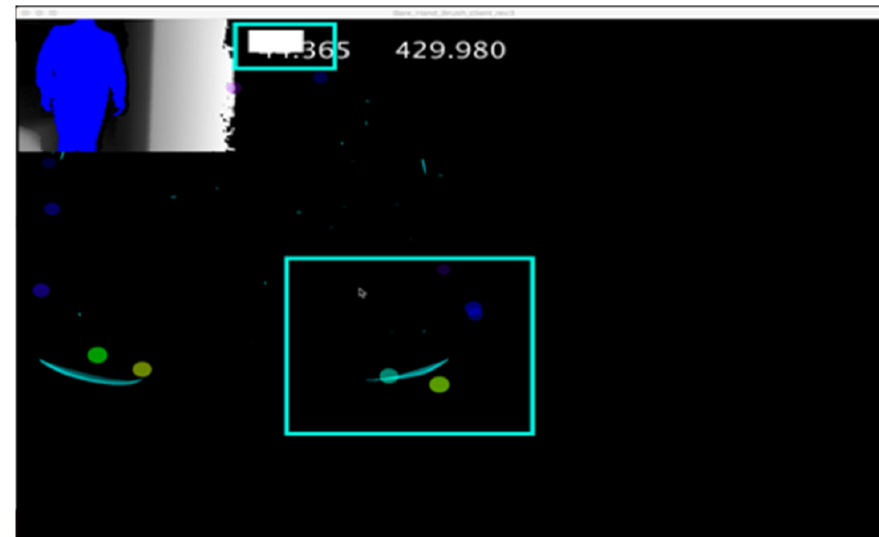
Figure 4. White rectangle on left side of the screen.